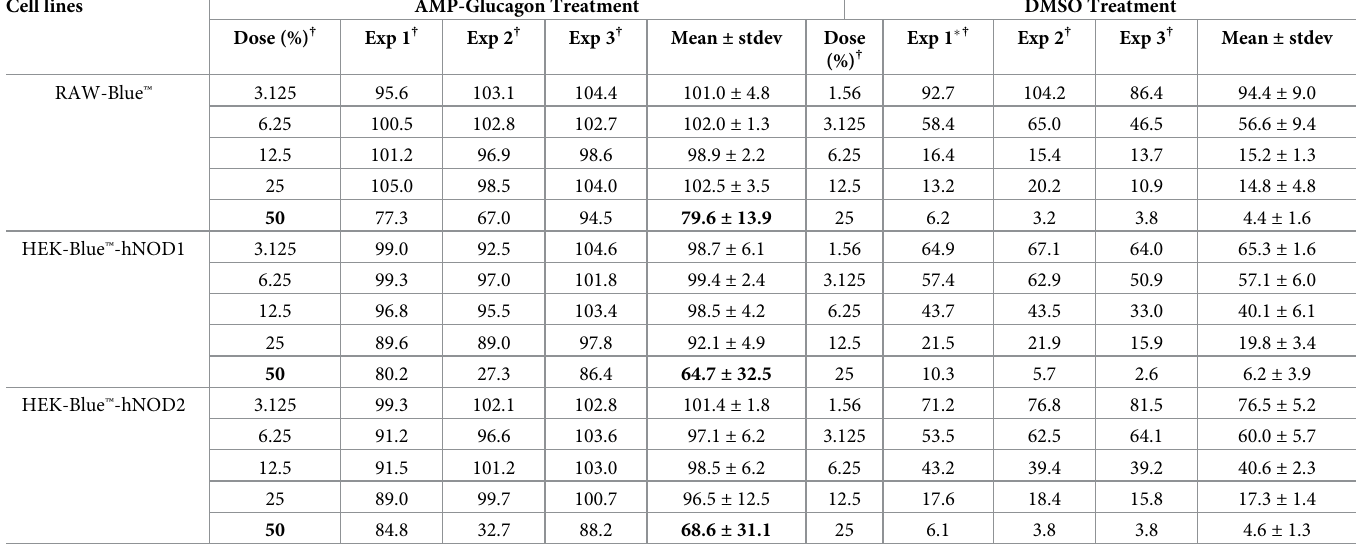
Table 1. Summary of the cell viability